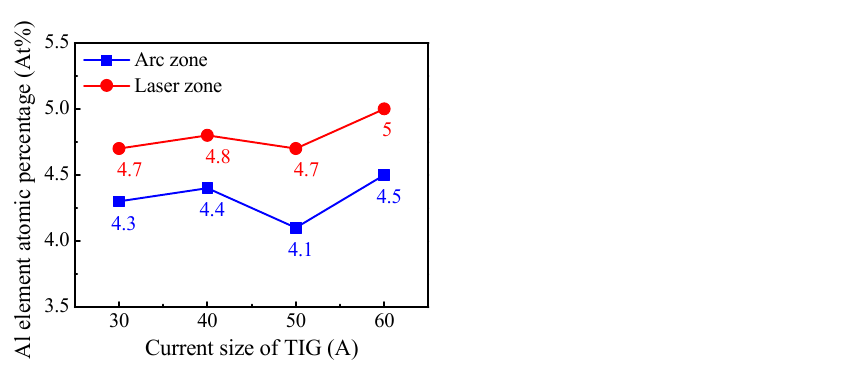
Figure 13. Atomic percentages of Al elements of arc zone and laser zone with different currents.